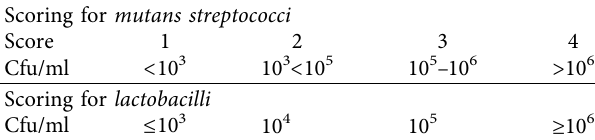
Table 1: Conversion to scores from